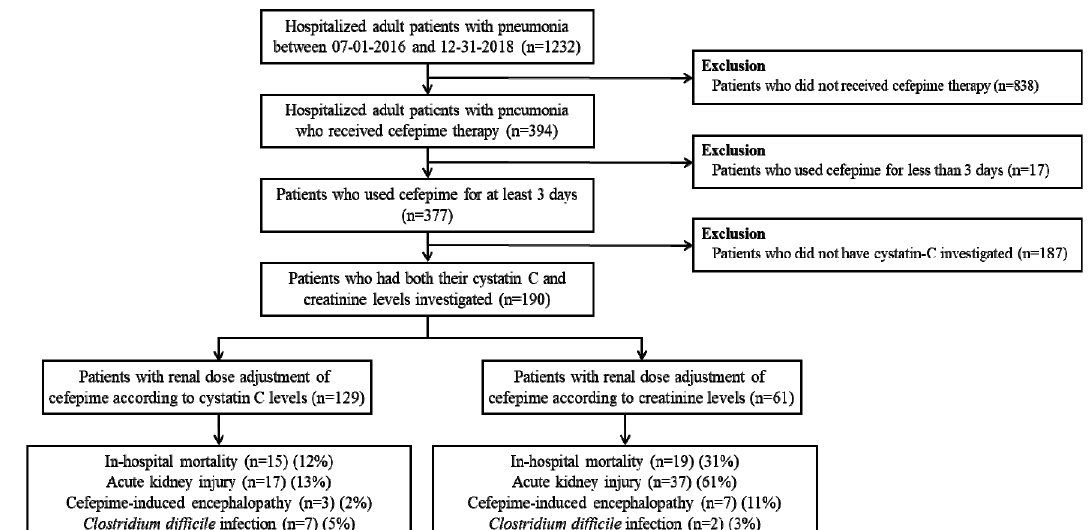
Figure 1. Flow diagram of the study.